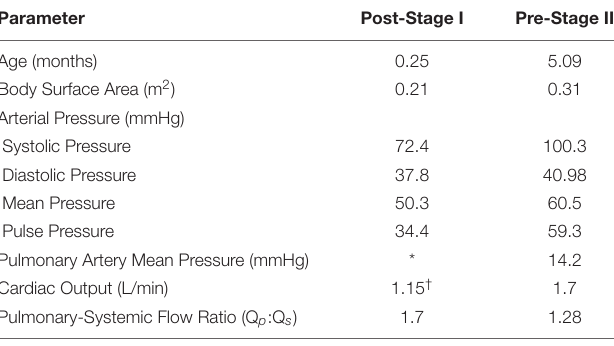
TABLE 1 | Literature-based weighted means of hemodynamic parameters for post-S1 and pre-S2.